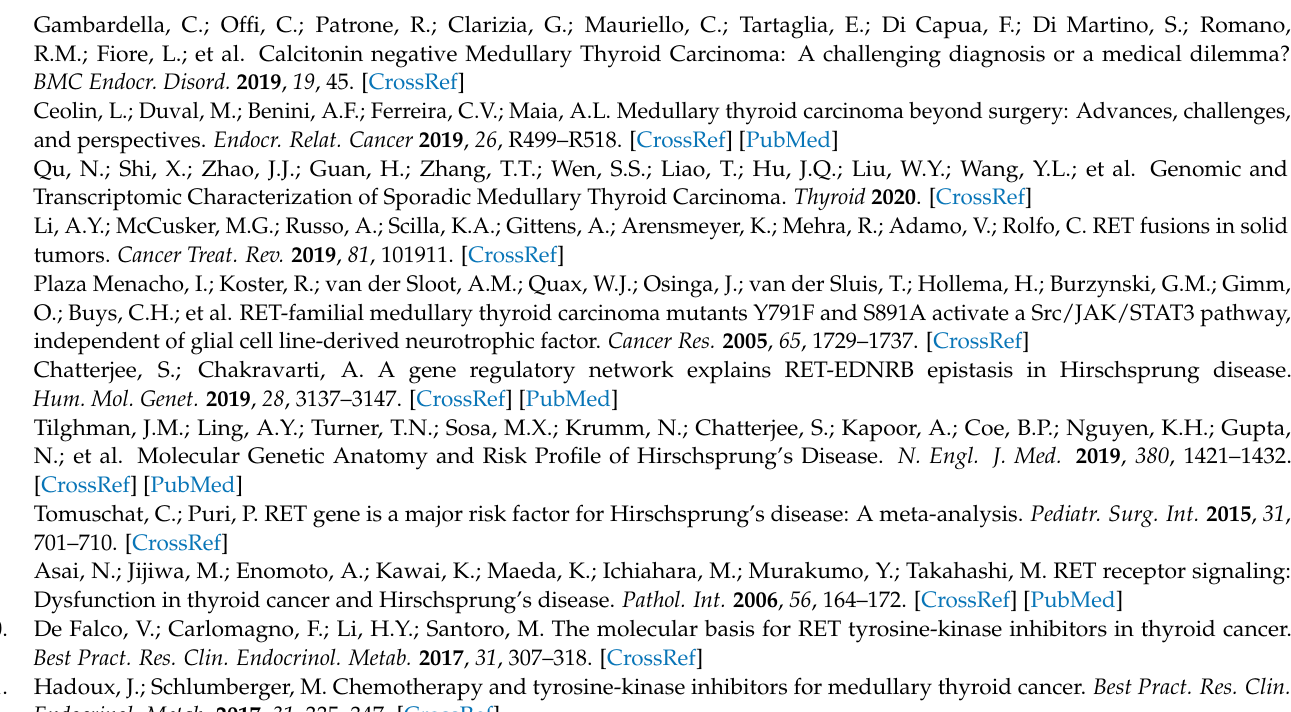
inhibition decelerates TT cell proliferation. Figure S3: GDNF-induced p35/CDK5 activity is ERK- EGR1 dependent. Figure S4: GDNF alters intracellular localization of CDK5 mainly at cell